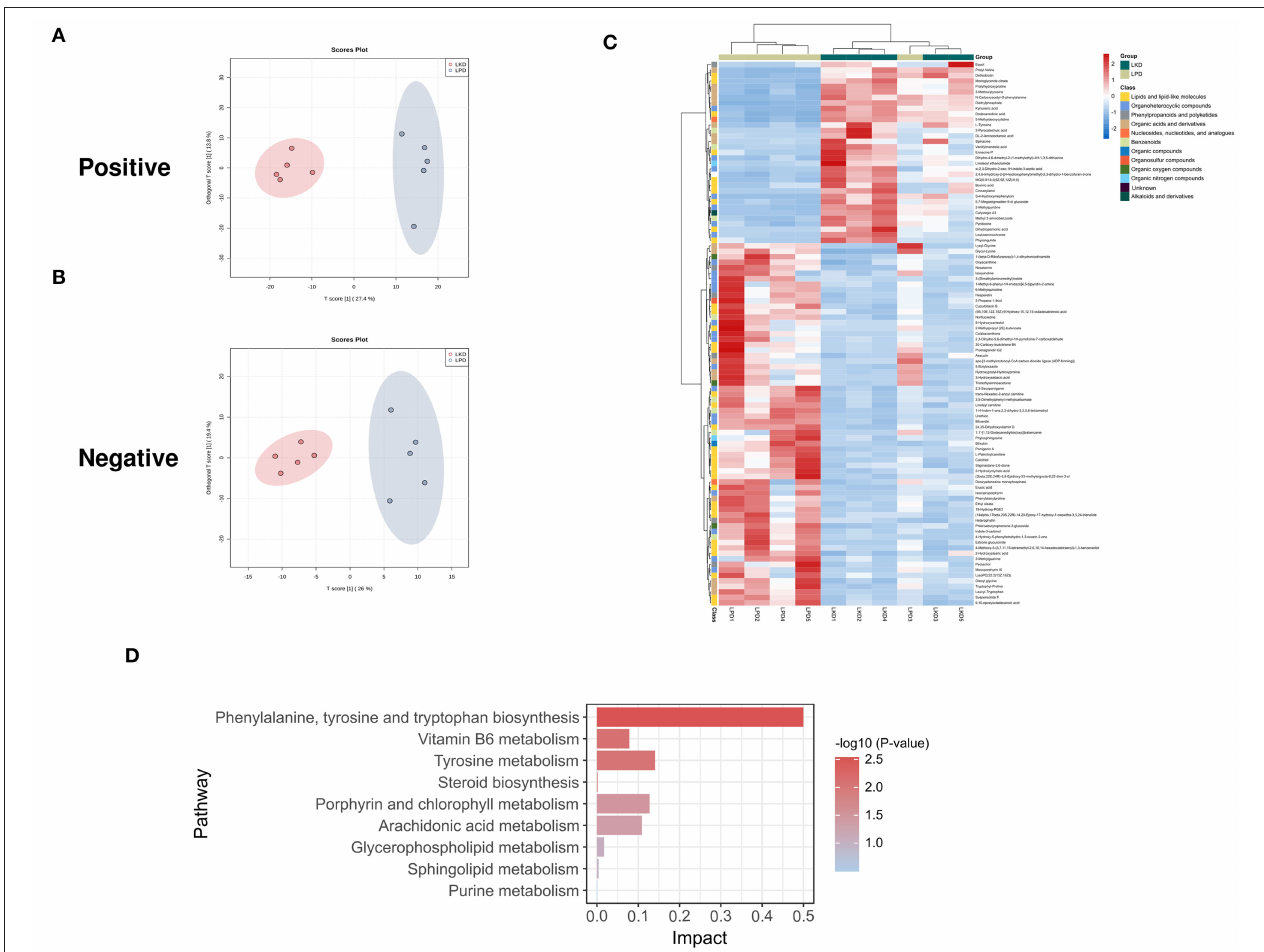
FIGURE 6 | Different expressed metabolites between LKD and LPD. (A) OPLS-DA score chart of positive mode between sham and LPD. (B) OPLS-DA score chart of negative mode between LKD and LPD. (C) Heatmap of 99 DEMs between LKD and LPD after combing positive and negative modes. The classification of these DEMs is indicated by different colors. (D) Enriched KEGG pathways of DEMs between LKD and LPD with p <